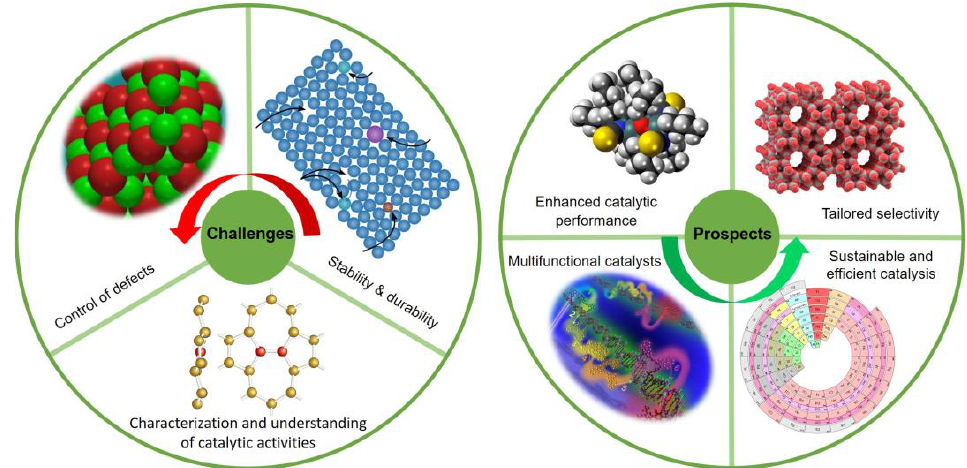
Figure 2. Challenges and prospects for defective catalysts.